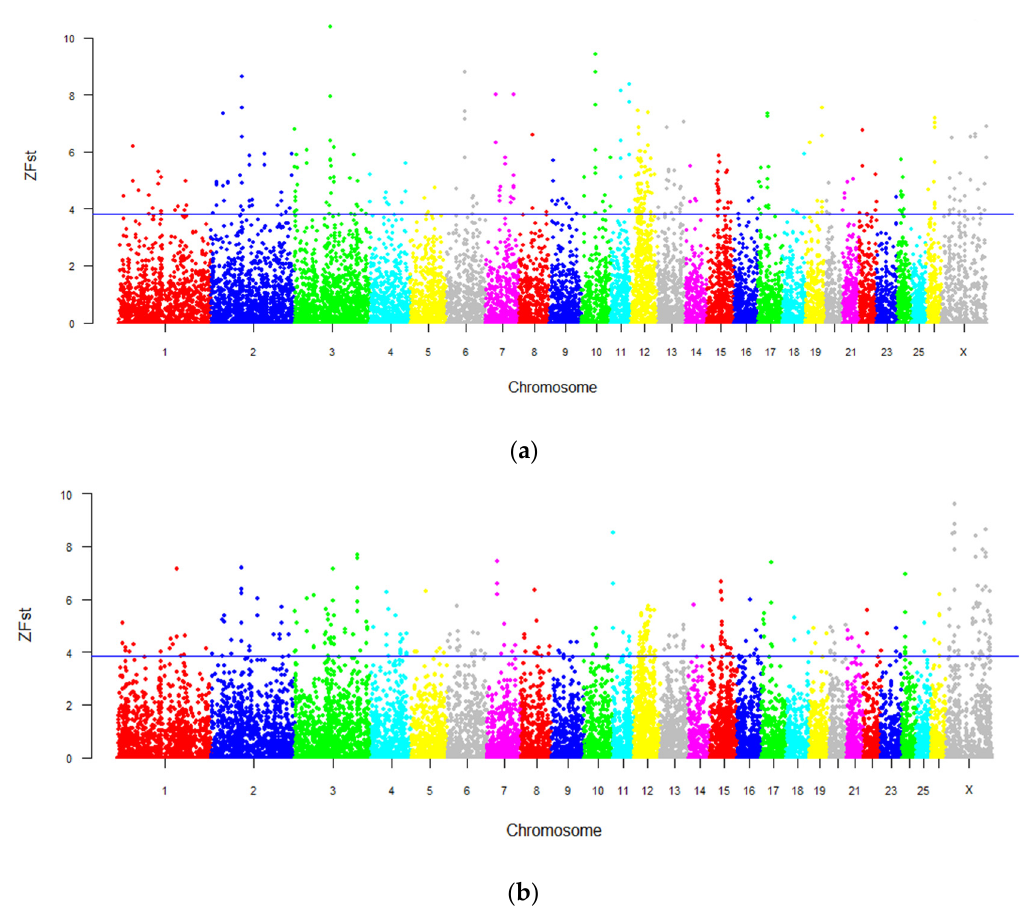
Figure 3. The detection of genome-wide selection signals in intersex and normal populations. ( a ) The genome-wide distribution of ZFst between intersex sheep and normal sheep (including normal Lanzhou large-tailed sheep and Tan sheep). ( b ) The genome-wide distribution of ZFst between intersex and normal individuals of Lanzhou large-tailed sheep. Note: The blue line represents the top 1% of the ZFst